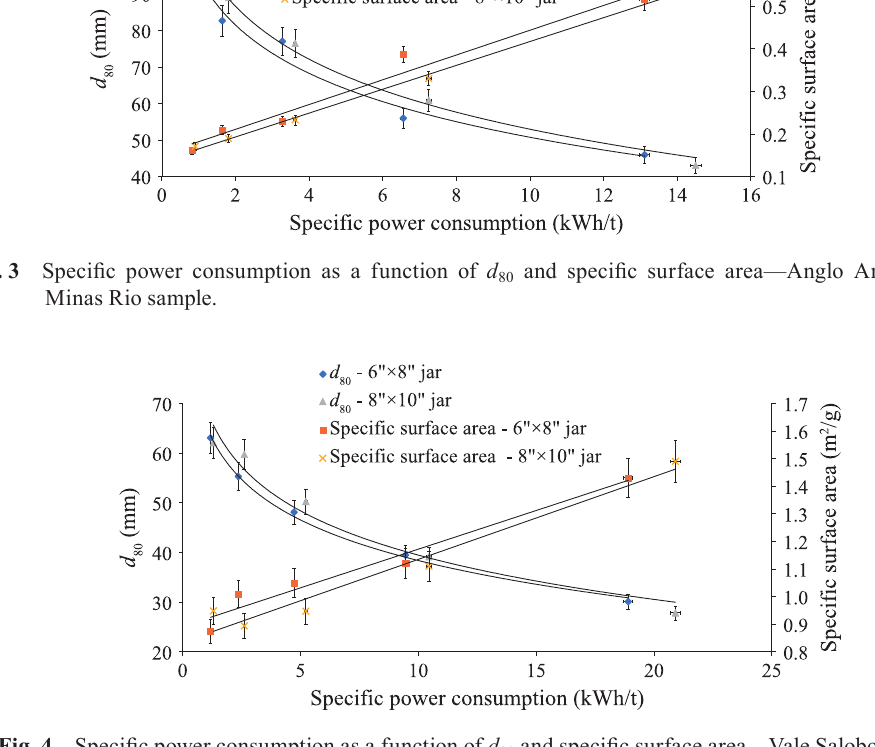
Fig. 4 Specific power consumption as a function of d 80 and specific surface area—Vale Salobo.